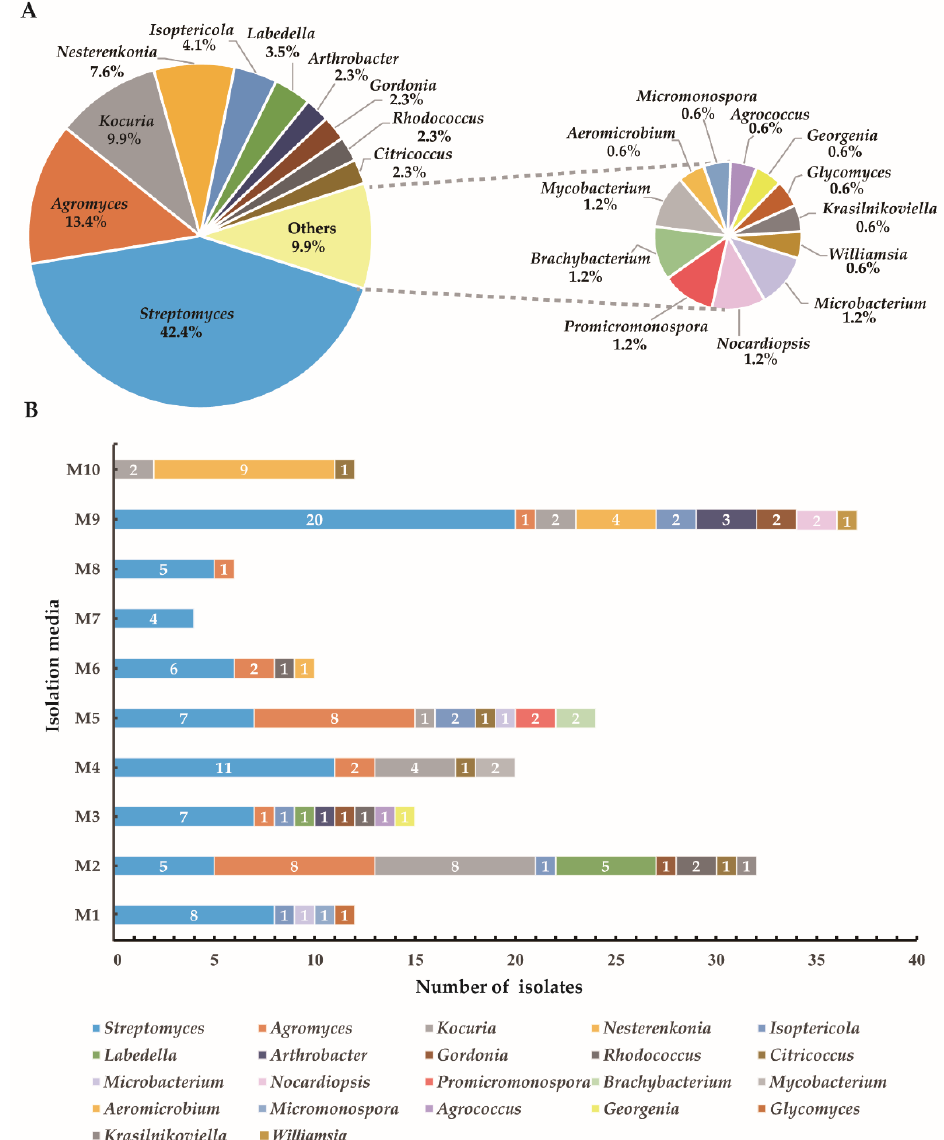
Figure 2. Diversity of cultivable actinobacteria recovered from the soil of the saxaul forest in the Southern Gobi Aimak in Mongolia. ( A ) Pie chart showing the percentage of recovered isolates affiliated with 22 different genera. ( B ) Numbers of actinobacteria in different genera isolated using ten selective culture media (M1 – M10). Compositions of the ten-culture media (M1 – M10) are shown in Supplementary Table S1.